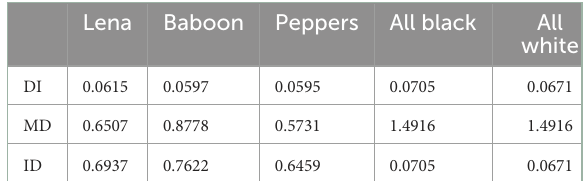
TABLE 6 Deviation of cipher images from ideality, maximum and irregular deviations between plain and cipher